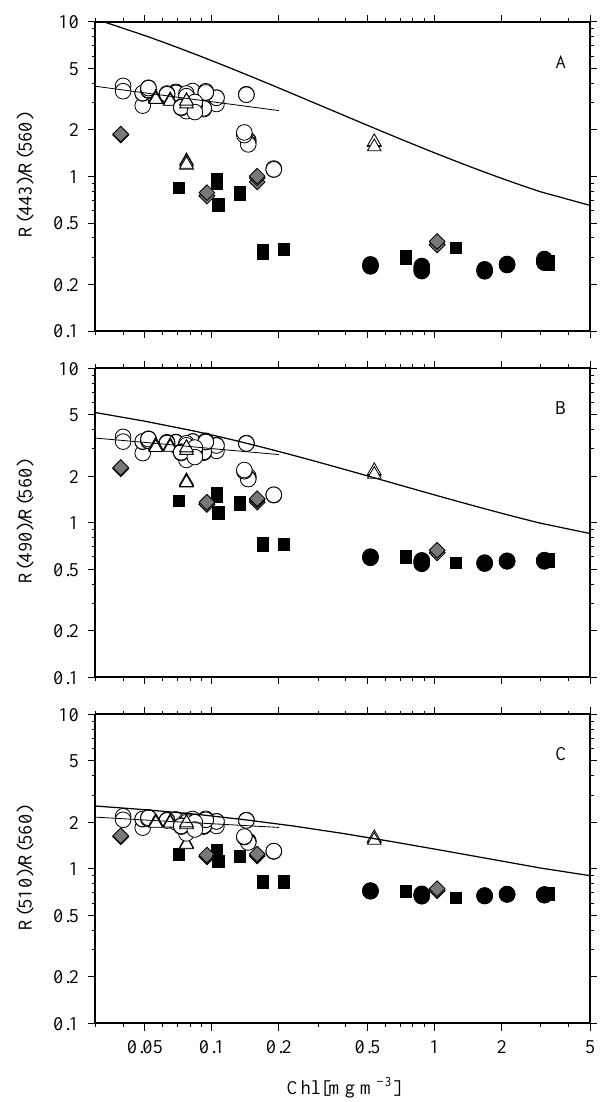
Fig. 7. Reflectance ratios for the wavelengths indicated, as a func- tion of the Chl a concentration. The thick solid curves show mod- eled values from Morel and Maritorena (2001). The thin solid curves are linear fits using the log-transformed data, for the clear- water stations